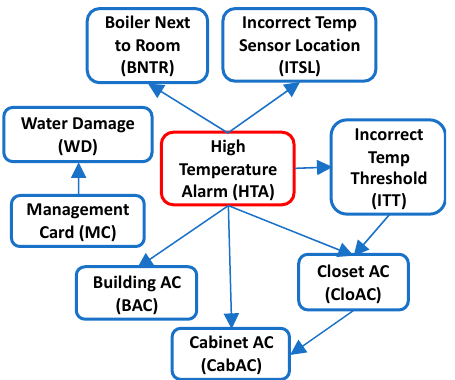
Figure 12. DAG structure for High Temperature Alarm learned using HC algorithm with binary variables.